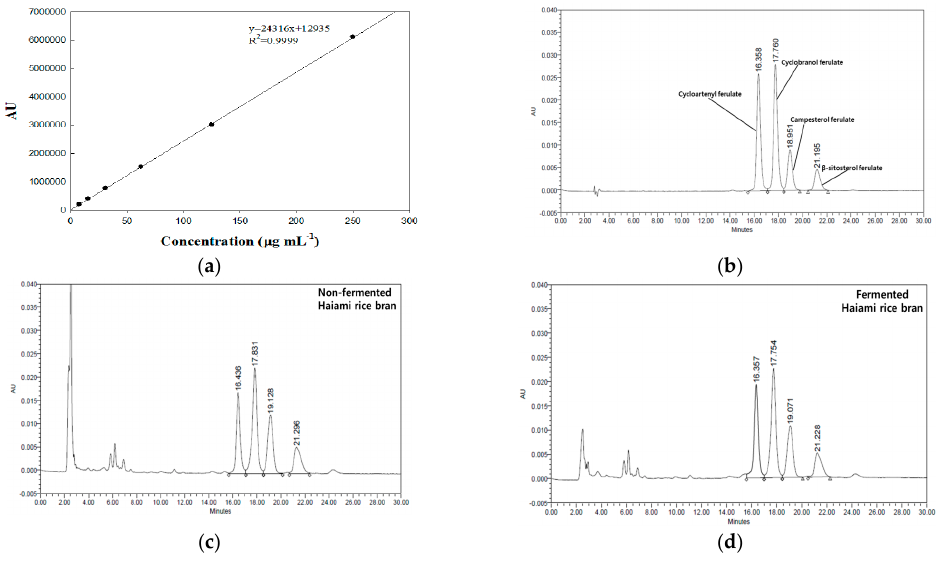
Figure 2. Linearity and specificity of γ -oryzanol. Calibration curve of γ -oryzanol standard solution ( a ); HPLC-PDA chromatograms of γ -oryzanol standard ( b ); non-fermented Haiami rice bran ( c ); and fermented Haiami rice bran ( d ). Table 2. Accuracy and precision of γ -oryzanol analysis for Oryza sativa cv. Haiami rice bran.